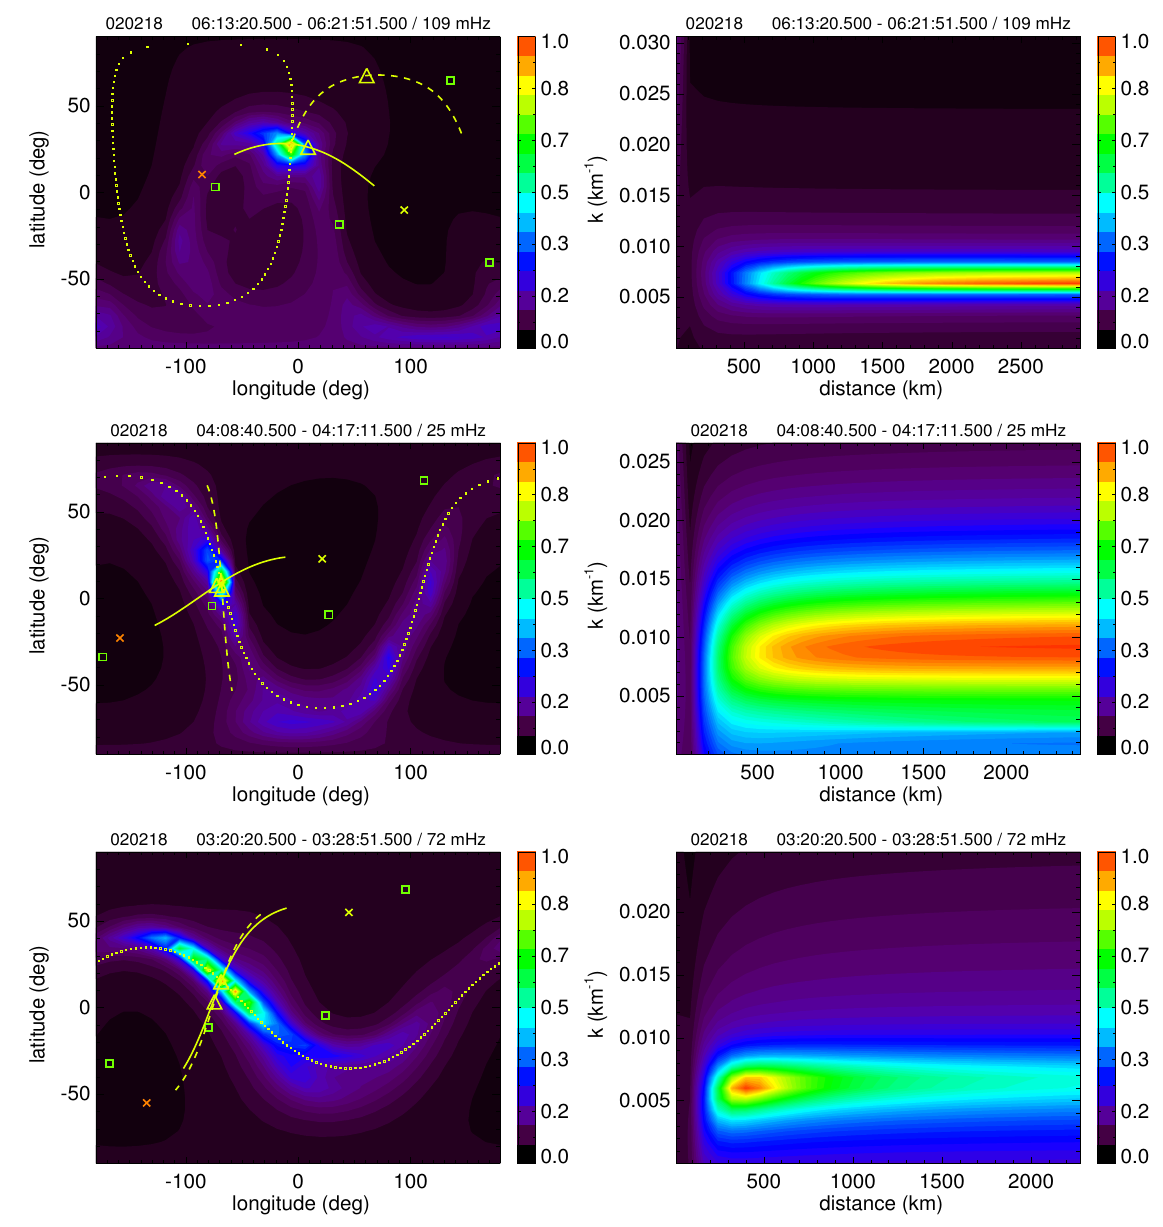
Fig. 6. Array power for data samples in different magnetospheric regions: From top to bottom: magnetosheath, magnetosphere, and cusp region. The magnetosheath wave propagates almost orthogonal to the mean magnetic field. This wave comes from a remote source. A remote source of orthogonal propagating waves is detected in the magnetosphere. Note the increased power along the “90 degrees line”. The cusp wave also propagates along the orthogonal direction to the mean magnetic field. Most of the power comes from a close source. However, there is an important contribution from an orthogonal propagating waves